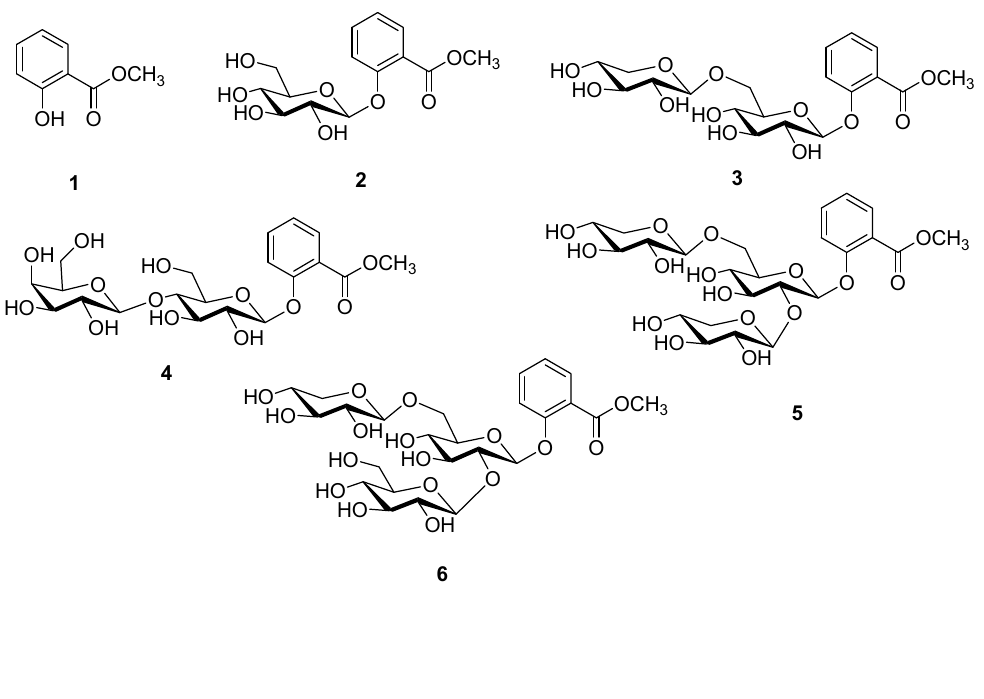
Figure 1. The structures of compounds 1 – 109 from